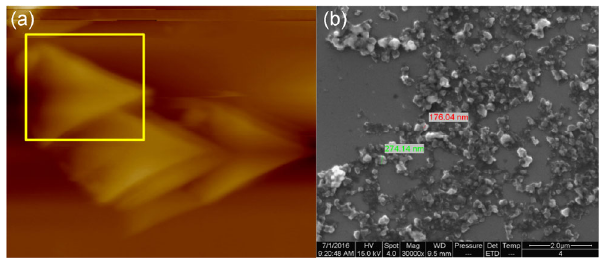
Fig. 9 (a) AFM image and (b) SEM image of BP nanosheets as water based dispersed